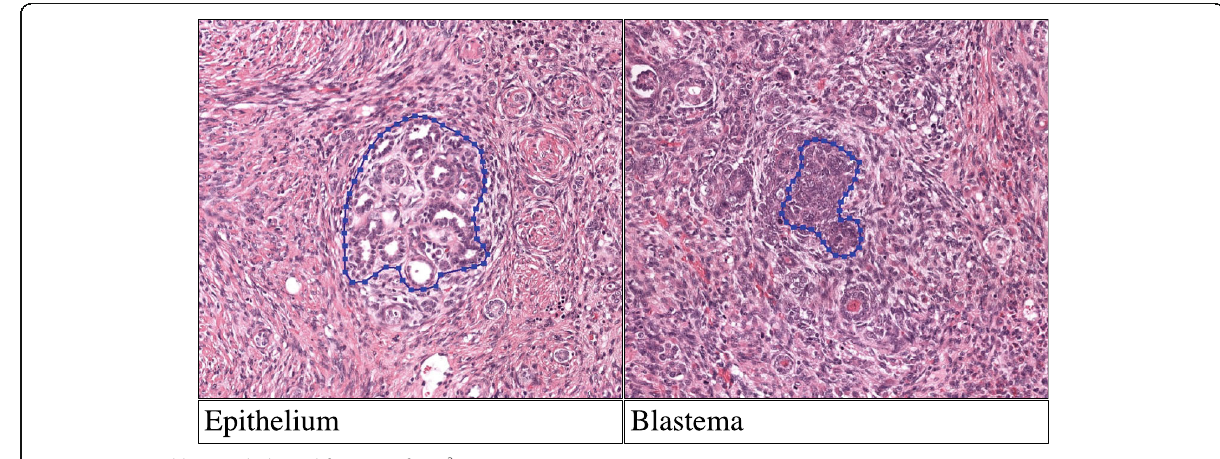
Fig. 1 Annotated histopathological features of WT a . a HE stained slide scanned at a 41x equivalent magnification (resolution 0.24 μ